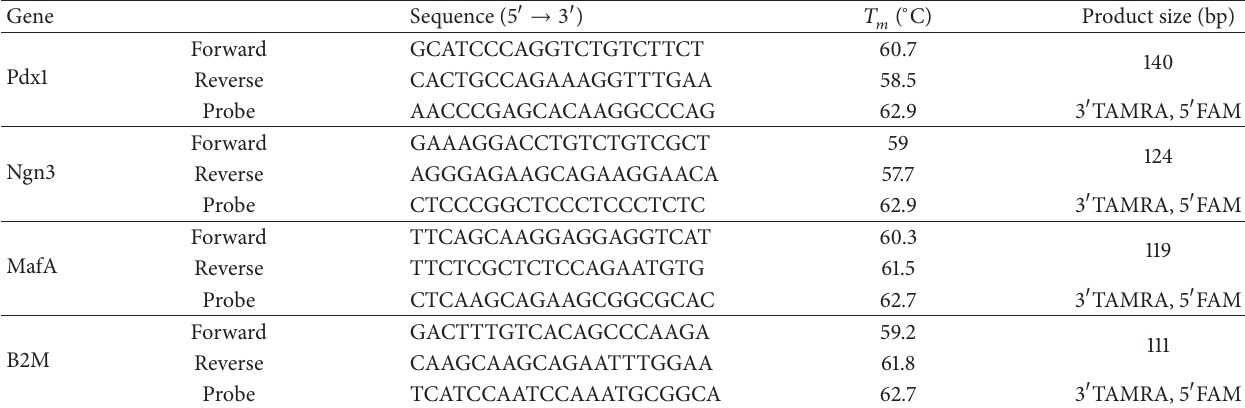
Table 2: Primers and probes used for qPCR